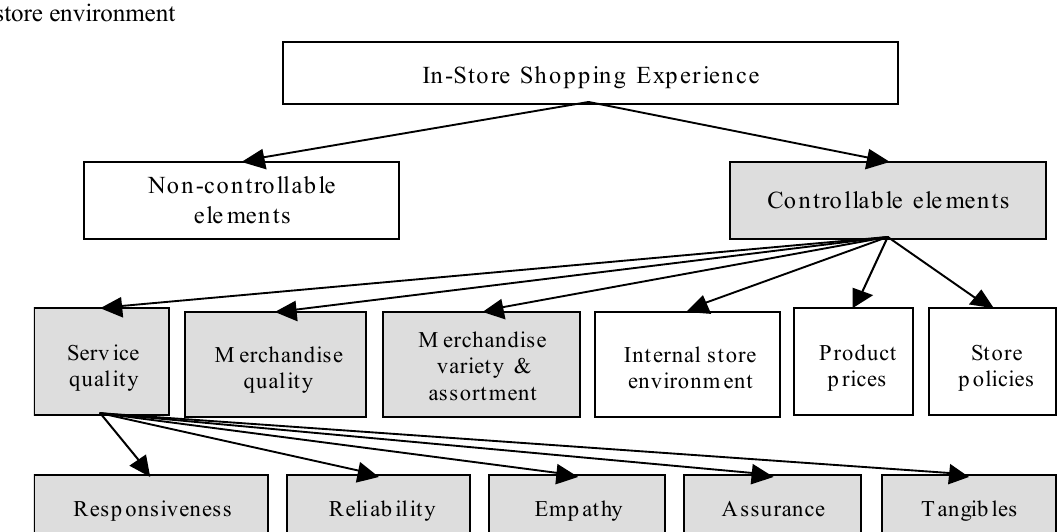
Figure 1: Schematic presentation of the theoretical structure of the in-store shopping